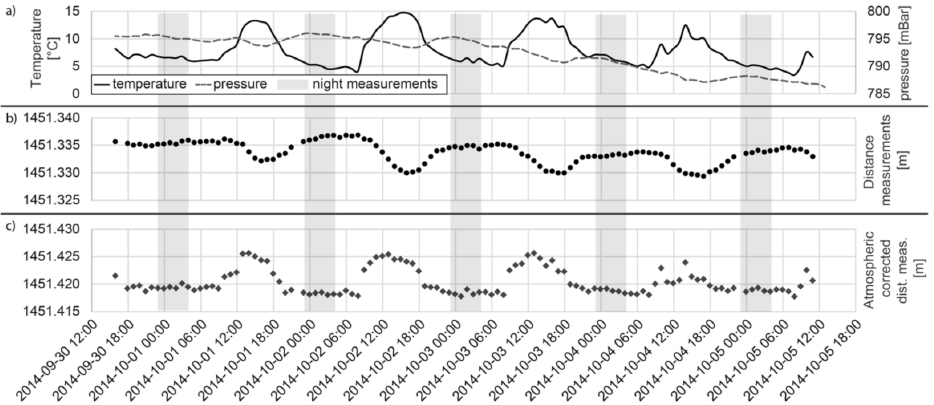
Figure 8. Impact of distance measurements from atmospheric inhomogeneities. ( a ) Temperature and atmospheric pressure at TPS2 Driest (Leica Nova TM50) over a 6-day period (30 September 2014 to 5 October 2014); ( b ) raw data distance measurements of reflector 54 measured across the valley at 1451 m distance; and ( c ) distance measurements after correction of atmospheric impacts due to temperature and pressure changes. The results confirm that our approach of only using nightly measurements (between 23:00 and 05:00, marked in grey) helped in obtaining a higher measurement repeatability during phases of a more stable